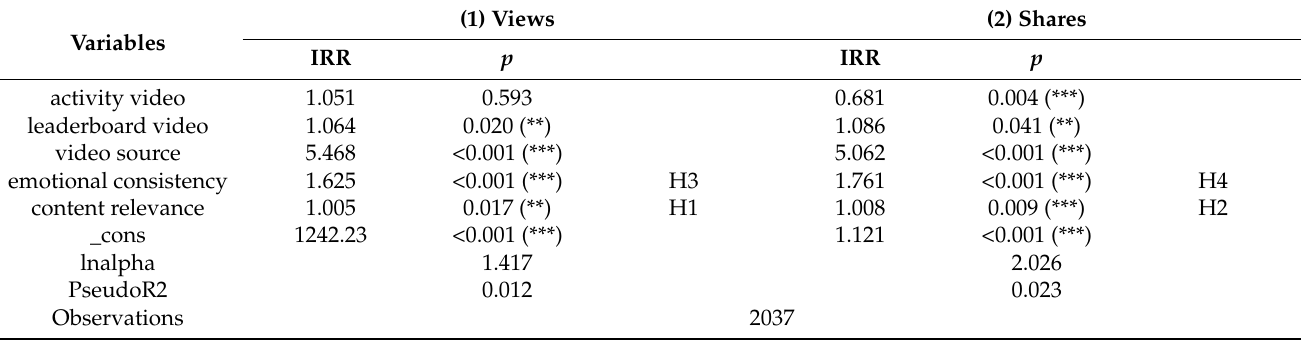
Table 5. Hypothesis